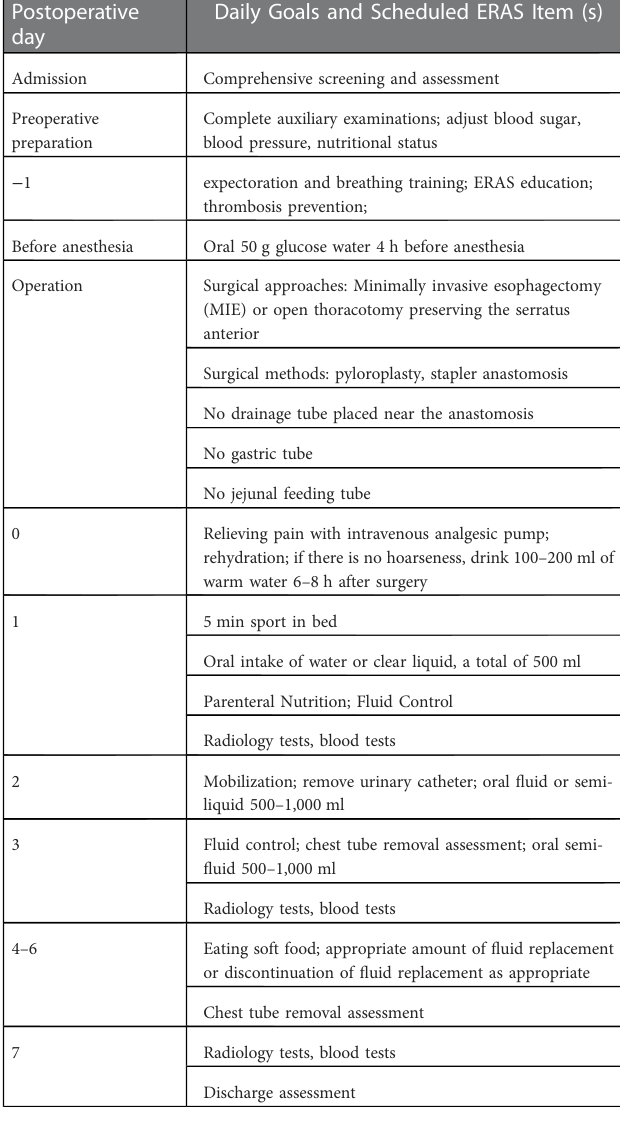
TABLE 1 Standardized ERAS protocol for